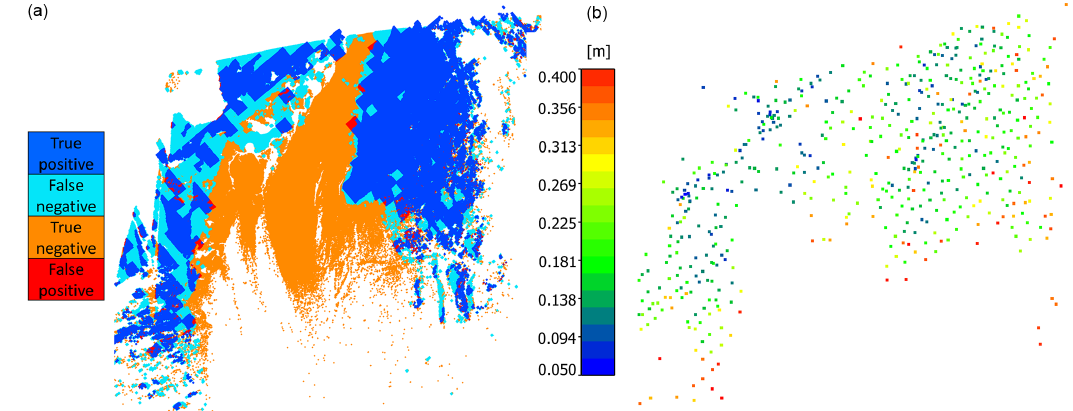
Figure 9. Confusion map (a) and spatial uncertainties for individual octree cells (b) .